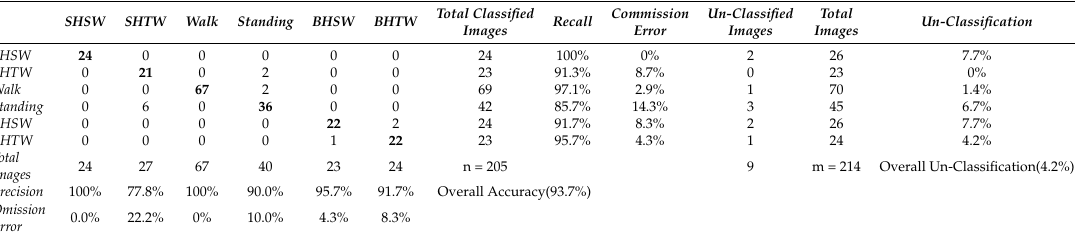
Table 7. Classification matrix for Lena